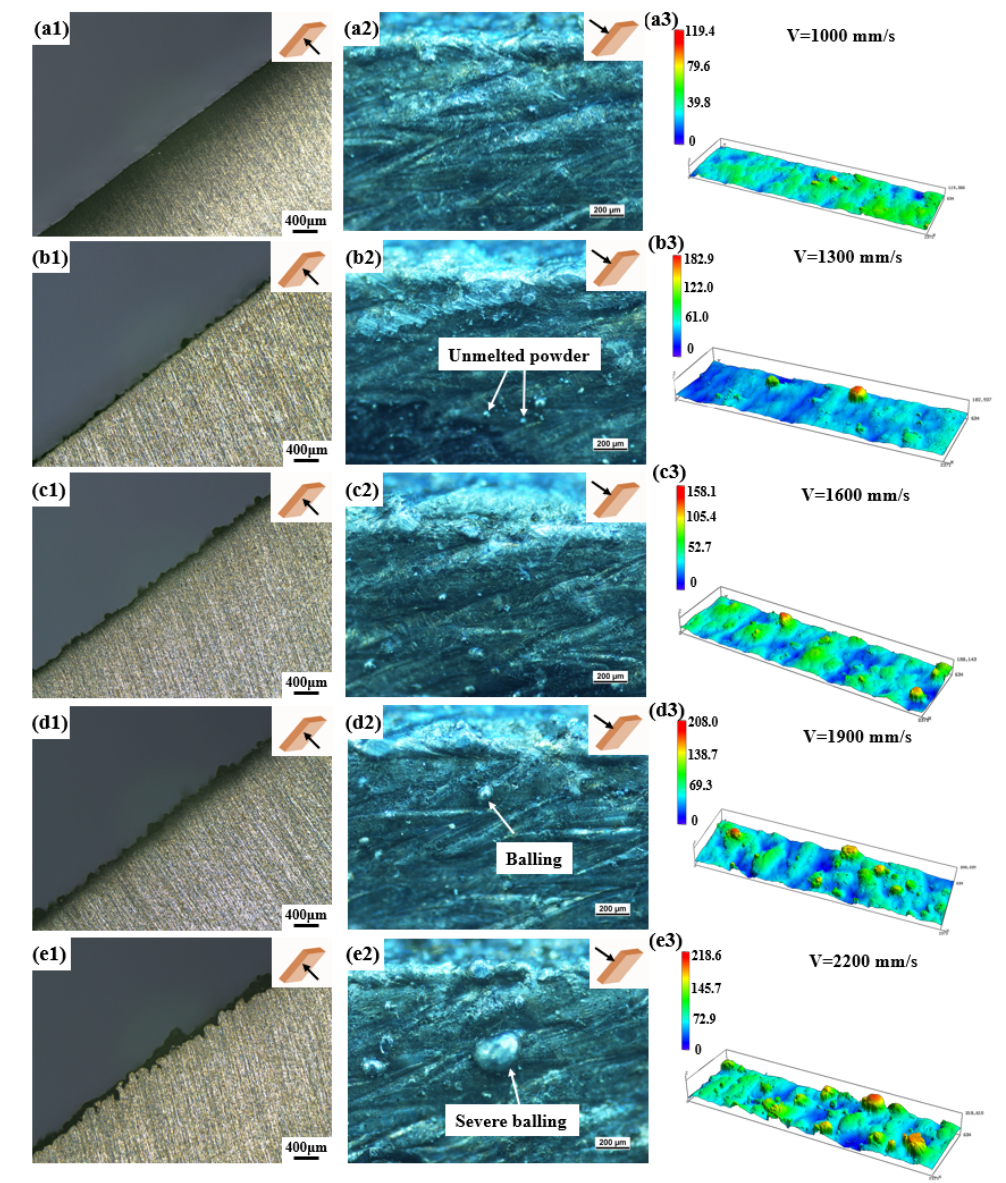
Figure 7. Optical microscopies and 3D surface morphologies with different contour scanning speeds (laser power ~100 W, beam offset ~0.07 mm): ( a1 – a3 ) V = 1000 mm/s, ( b1 – b3 ) V = 1300 mm/s, ( c1 – c3 ) V = 1600 mm/s, ( d1 – d3 ) V = 1900 mm/s, ( e1 – e3 ) V = 2200 mm/s (inset pictures show the observation orientation).